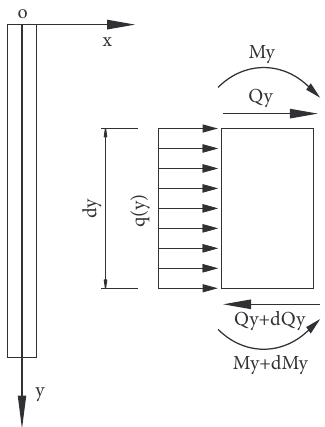
Figure 2: Internal force calculation of stabilizing